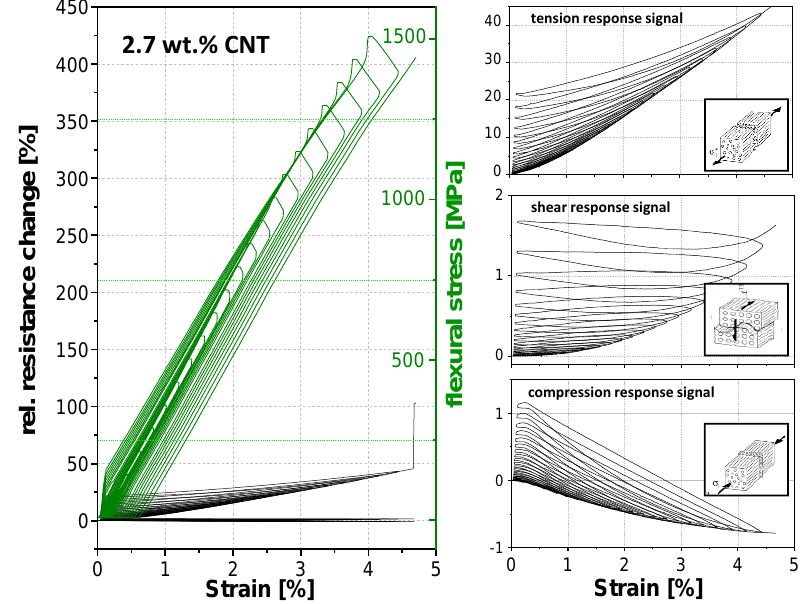
Figure 11. Cyclic electromechanical response behavior of nanostructured sensor fiber using 2.7 wt. % CNT embed in the planes of maximum stresses for compression, shear and tension, during a quasi-static three-point bending (Span to Length L/h ratio of 33, a stepwise increase of a mechanical loading of 50 MPa).